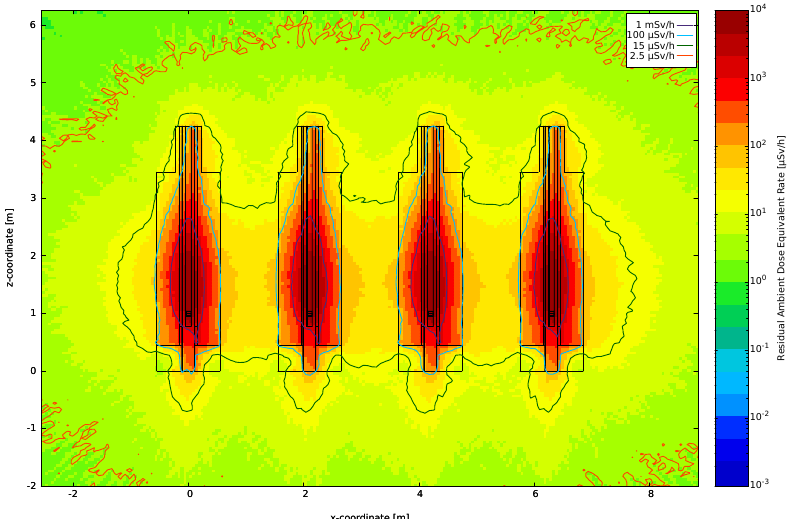
Figure 5. Storing of all LHC TAN in surface. LS3, 4 months cool down after end of p-p operation.